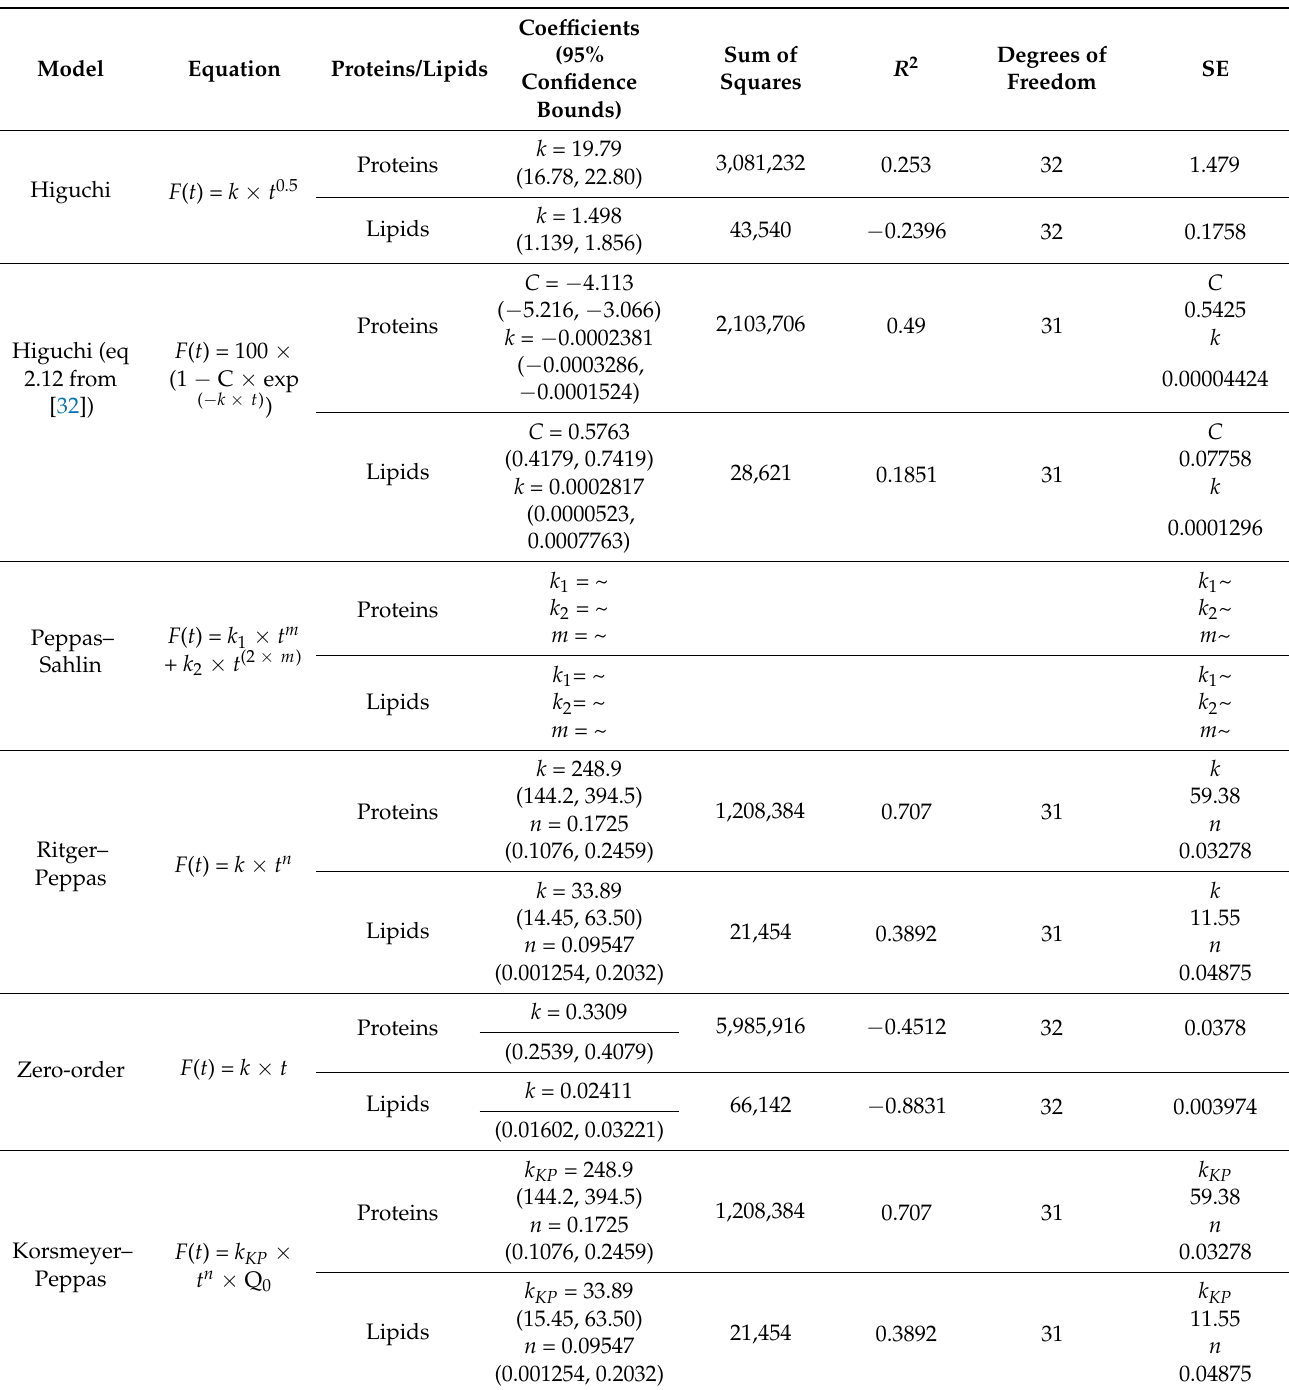
Table 1. Results of in vitro release model fitting for proteins and lipids from SBlyo. Kinetic elaborations were performed on release data obtained from at least three independent experiments for each batch. “~” indicates that the analysis performed was “ambiguous”; therefore, the fit does not nail down the values of all the parameters, and 95% confidence bounds cannot be reported. These latter data were not considered in the interpretation of